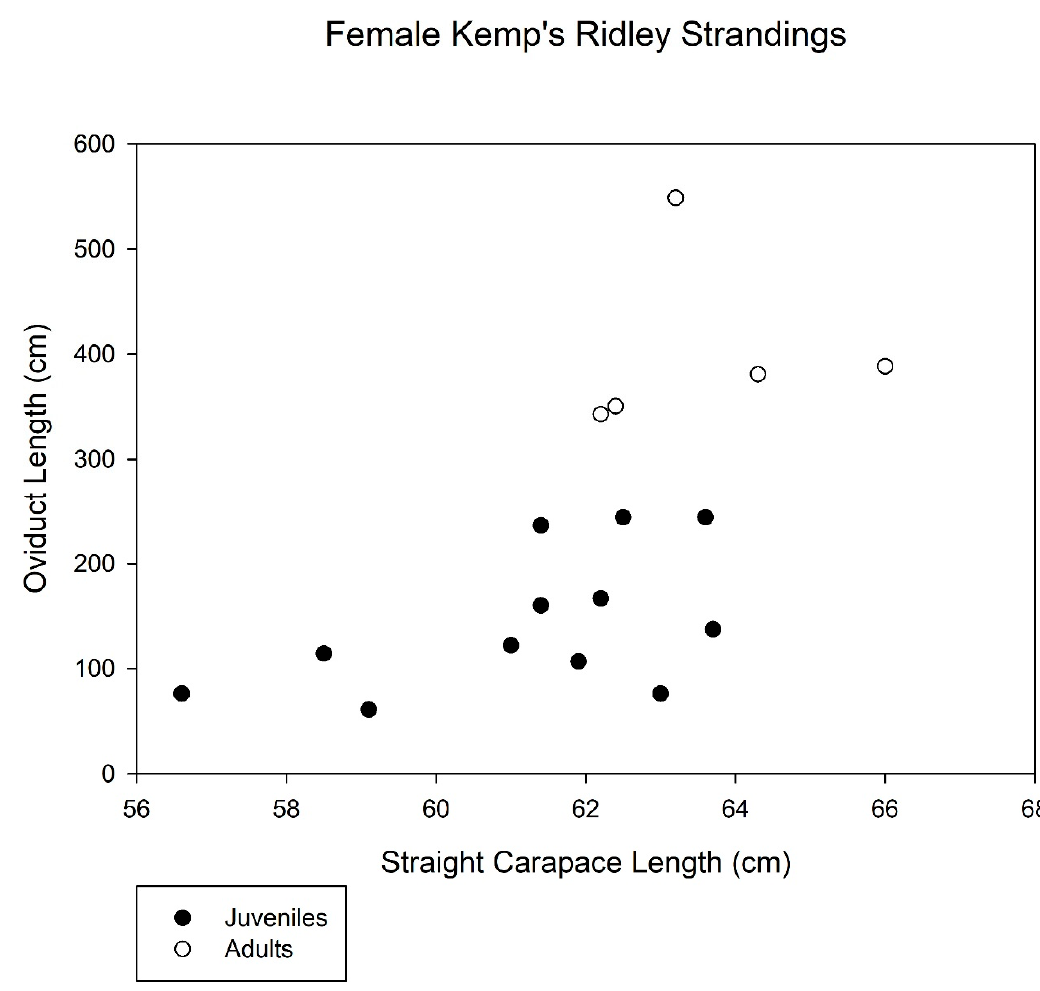
Figure 1. Comparison between the oviduct length and straight carapace length measured in stranded female Kemp’s ridley sea turtles, Lepidochelys kempii .